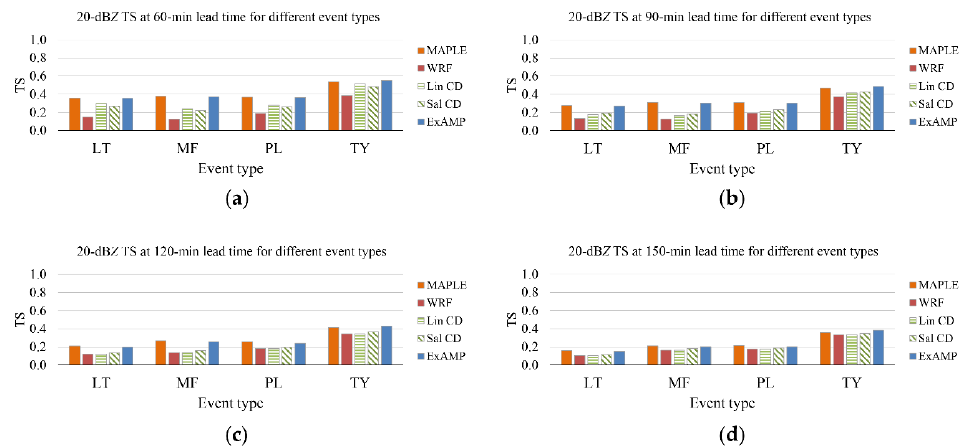
Figure 8. The TSs of MAPLE, WRF, Lin CD, Sal CD, and ExAMP for the LT, MF, PL, and TY event types above the 20 dB Z threshold at the lead times of ( a ) 60, ( b ) 90, ( c ) 120, and ( d ) 150 min, computed over the grid points with observed reflectivity exceeding 0 dB Z .